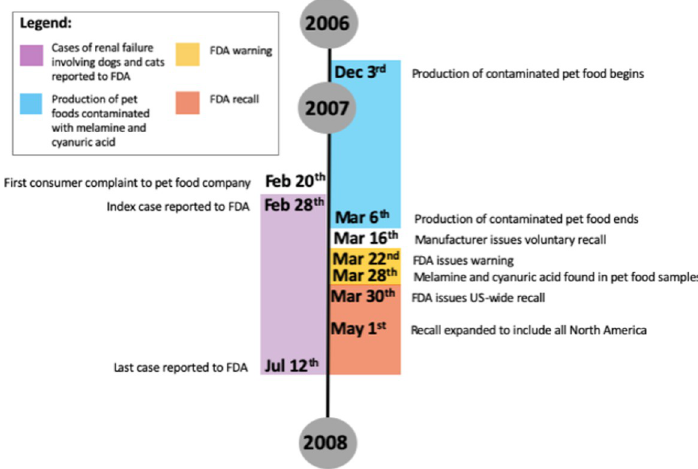
Fig 1. A timeline of the 2007 melamine pet food contamination outbreak in North